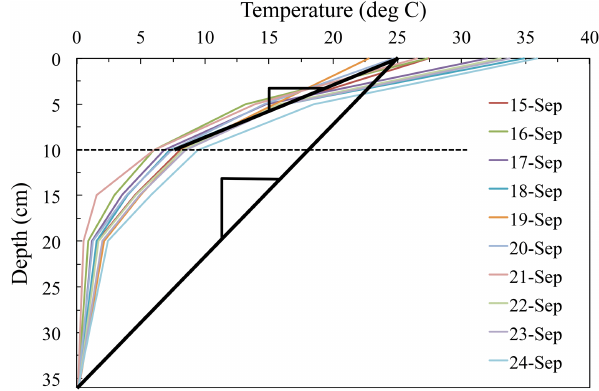
Figure 4. Temperature profiles at site LT3 at 10:15 with the temper- ature gradients used to compute G ratio